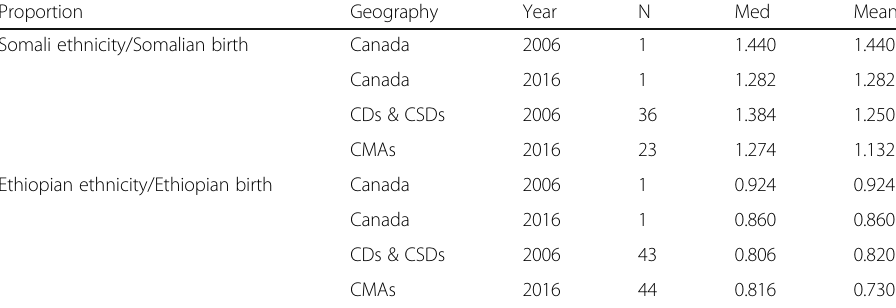
Table 4 Median and mean proportions of ethnicity to birth for first-generation Somalis and Ethio- pians, 2006 and 2016 censuses Proportion